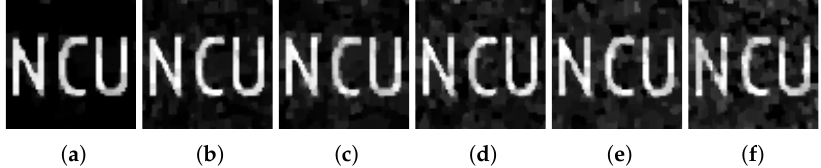
Figure 11. When the sampling rate is 0.1, the image reconstructed from the original image measured by adaptive measurement matrix added with a mean of 0 and variance of ( a ) 0, ( b ) 0.02, ( c ) 0.04, ( d ) 0.06, ( e ) 0.08, and ( f ) 0.1. The reconstructed algorithm is TVAL3. The resolution of the image is 64 × 64 for all.